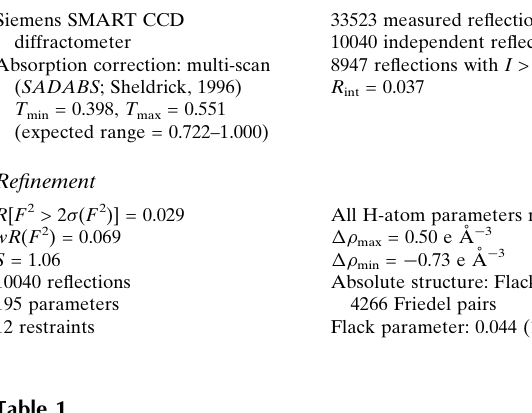
Hydrogen-bond geometry (A˚ , (cid:3)